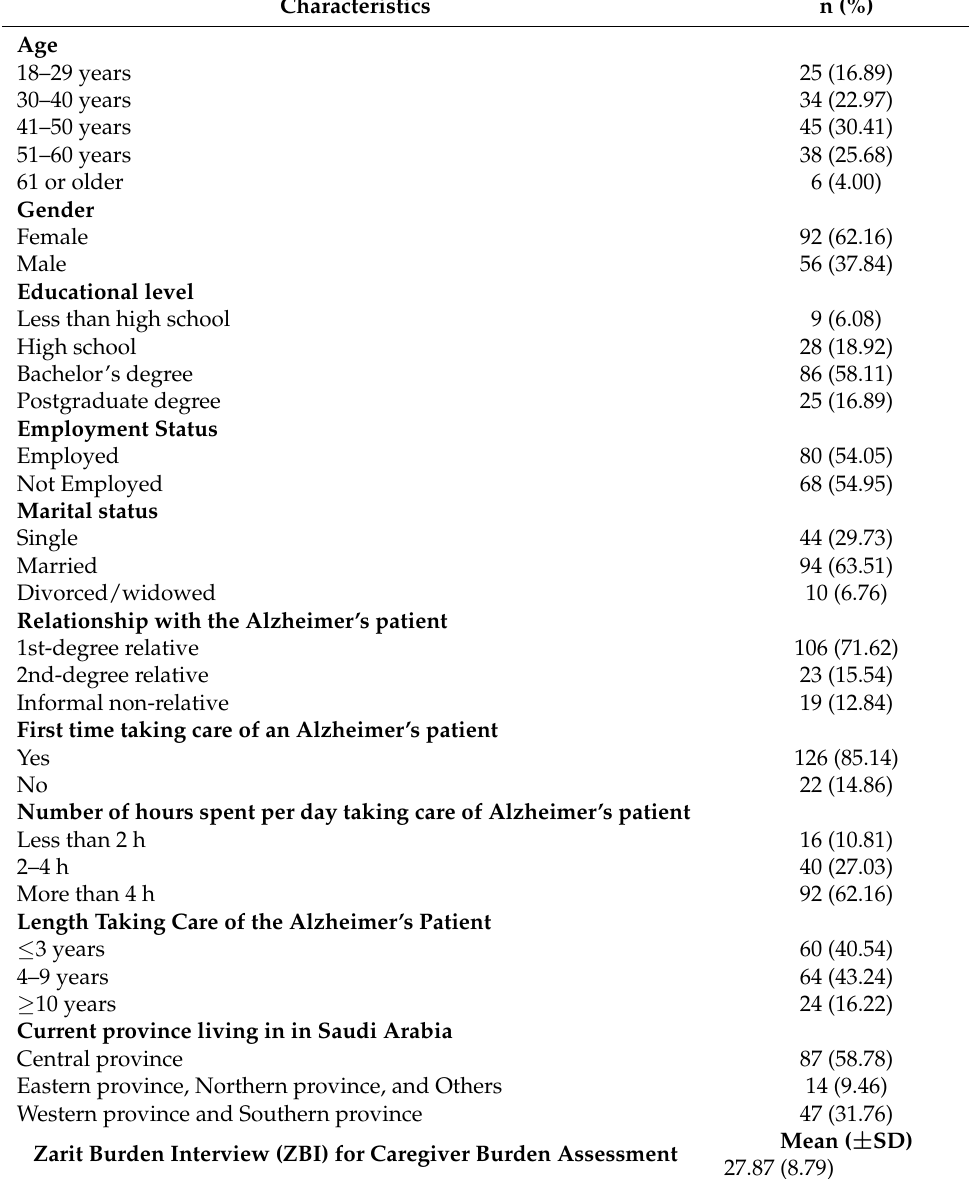
Table 1. Baseline Demographics and Characteristics of Caregivers for Alzheimer’s